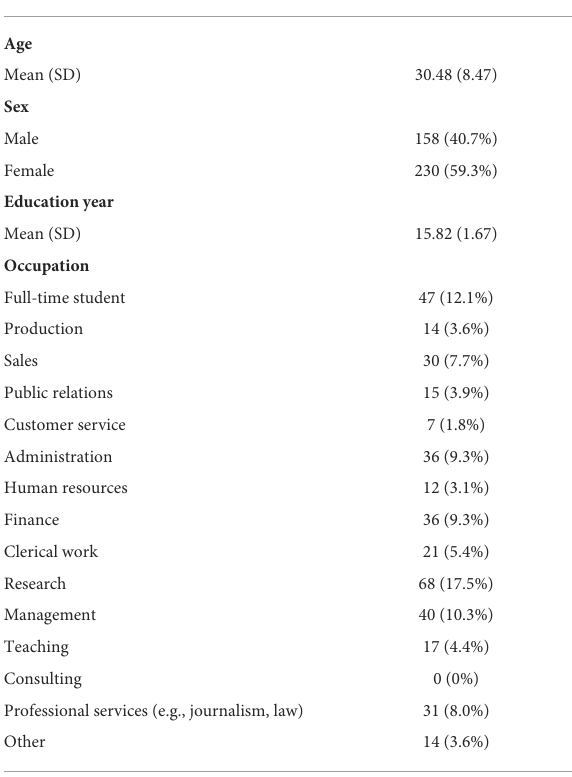
TABLE 5 Demographic characteristics ( N =